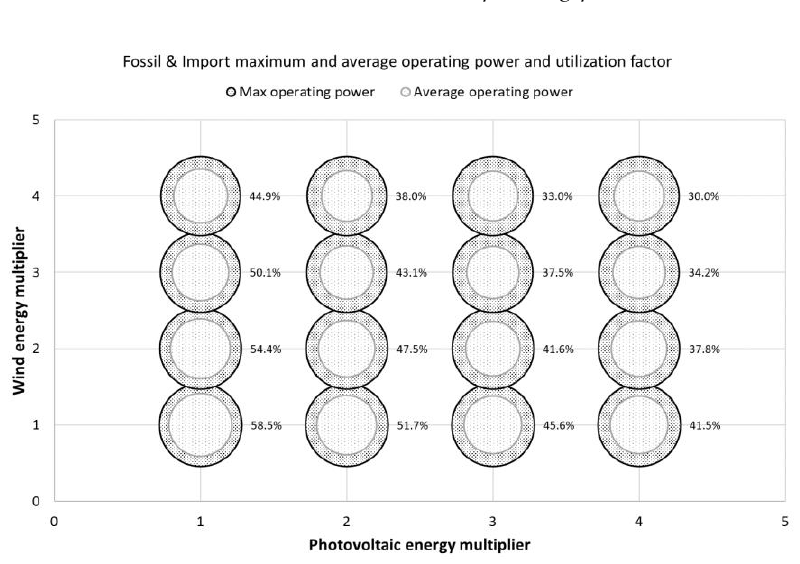
Figure 20. Maximum and average operating power for traditional energy sources, and utilization factors for different values of wind and photovoltaic productions.